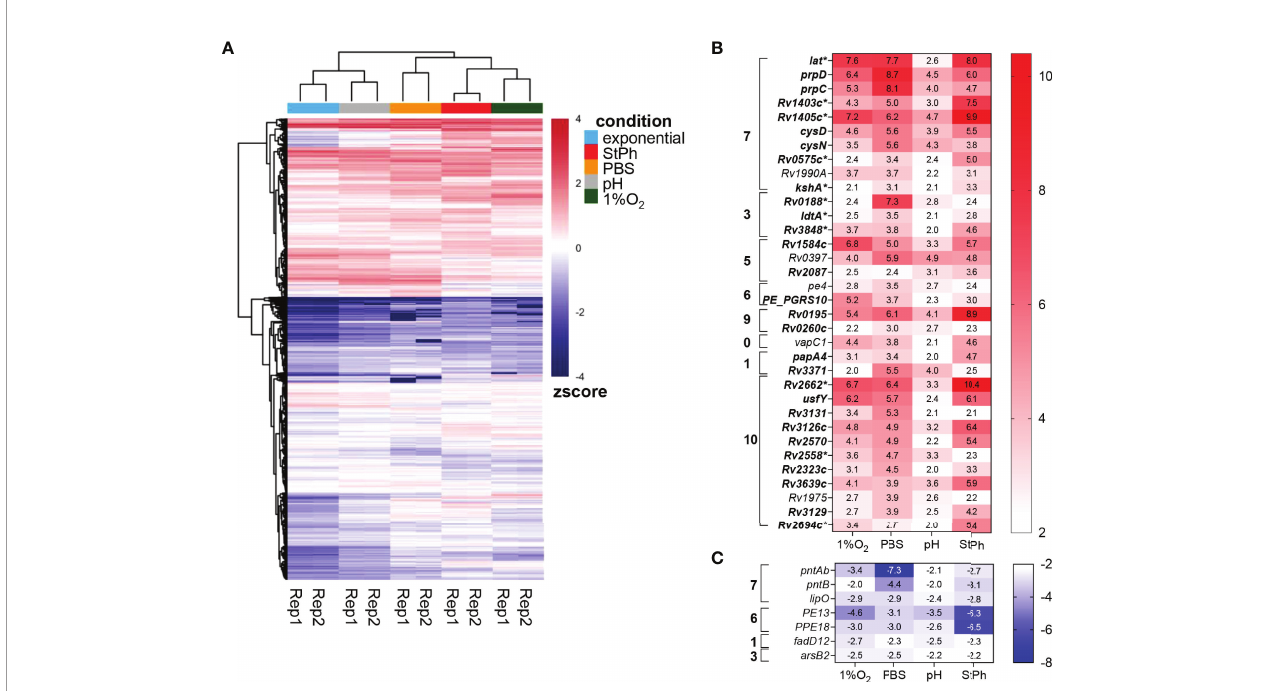
FIGURE 1 | (A) Heat map showing the expression level of 4014 genes using Z-score for normalized FPKM value. Red represents high expression level, while blue represents low expression level. The two-way hierarchical clustering is based on euclidean distance, showing similarity between different samples. (B, C) Heat map of the genes up- (B) and down-regulated (C) in all stress conditions. The log2 fold change is indicated in each cell for the speci fi c gene/stress condition combination: hypoxic, 1%O 2 ; nutrient starvation, PBS; acidic, pH; stationary phase, StPh. Functional categories are as follows: 0 virulence, detoxi fi cation, adaptation; 1 lipid metabolism; 2 information pathways; 3 cell wall and cell processes; 5 insertion seqs and phages; 6 PE/PPE; 7 intermediary metabolism and respiration; 9 regulatory proteins; 10 conserved hypotheticals. *Genes part of the enduring hypoxic